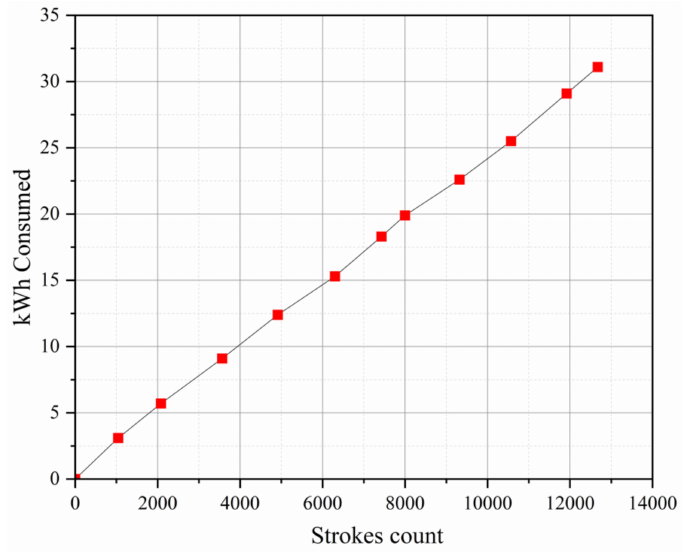
Figure 4. Electrical energy consumption variation with press stroke counts with DOL control.